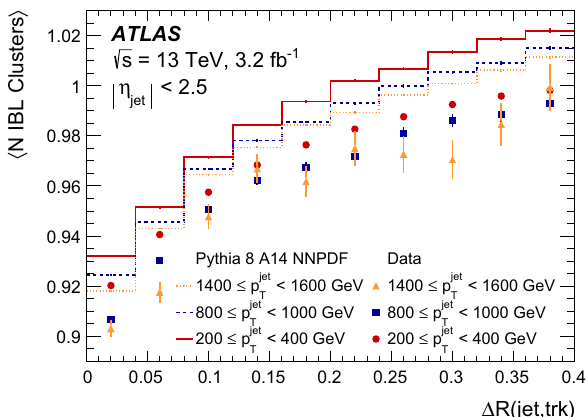
in the presence of highly collimated charged particles.